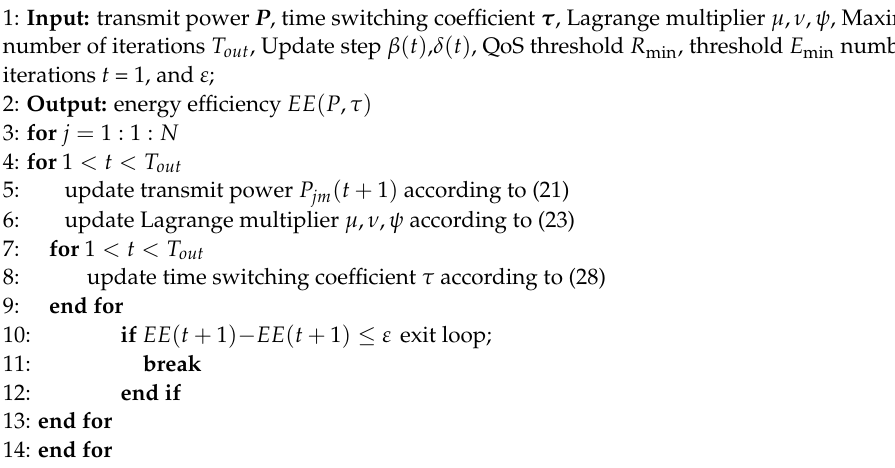
Algorithm 1. Two-layer iteration for power allocation and time